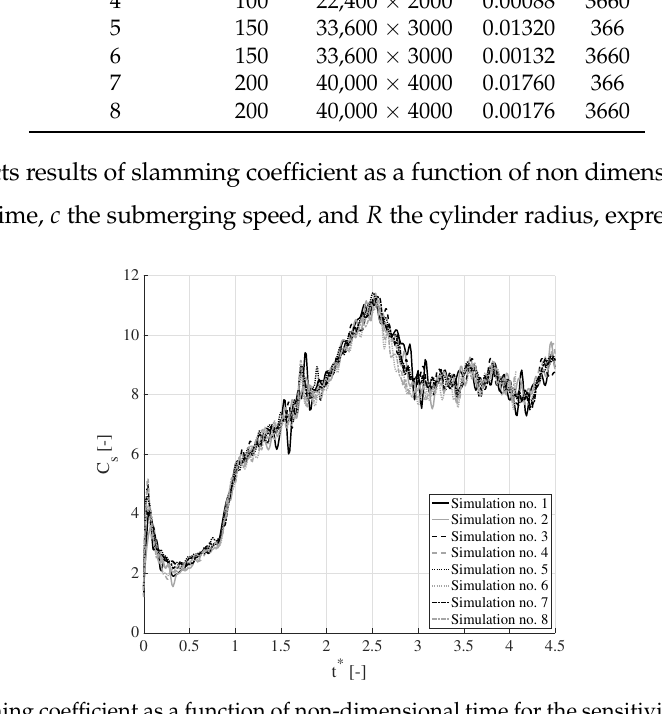
Figure 6. Slamming coefficient as a function of non-dimensional time for the sensitivity matrix reported in Table 3. Black curves are related to low Re, gray ones to high Re. Solid line refers to D = 50LU, dashed ones to D = 100LU, dotted ones to D = 150LU, and dash-dotted ones to D =